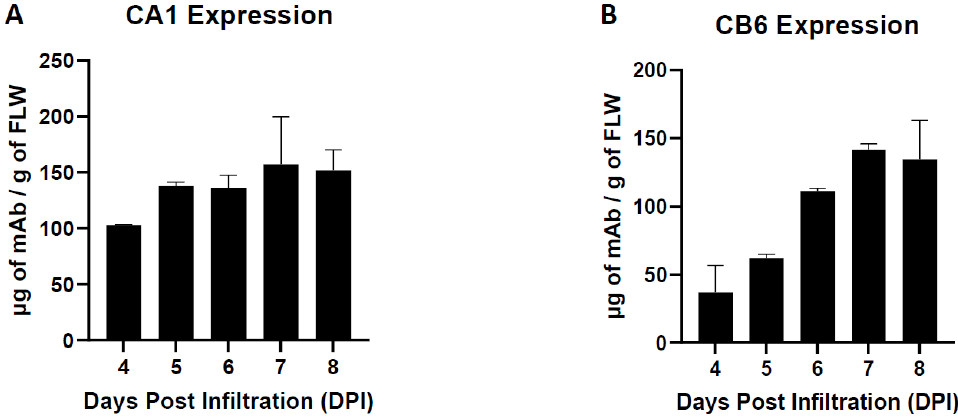
Figure 3. Temporal expression of CA1 (A) and CB6 (B) in N. benthamiana . Total soluble plant extracts were analyzed over time by sandwich ELISA that detects fully assembled human IgG. Mean ± SEM is plotted from two independent experiments.